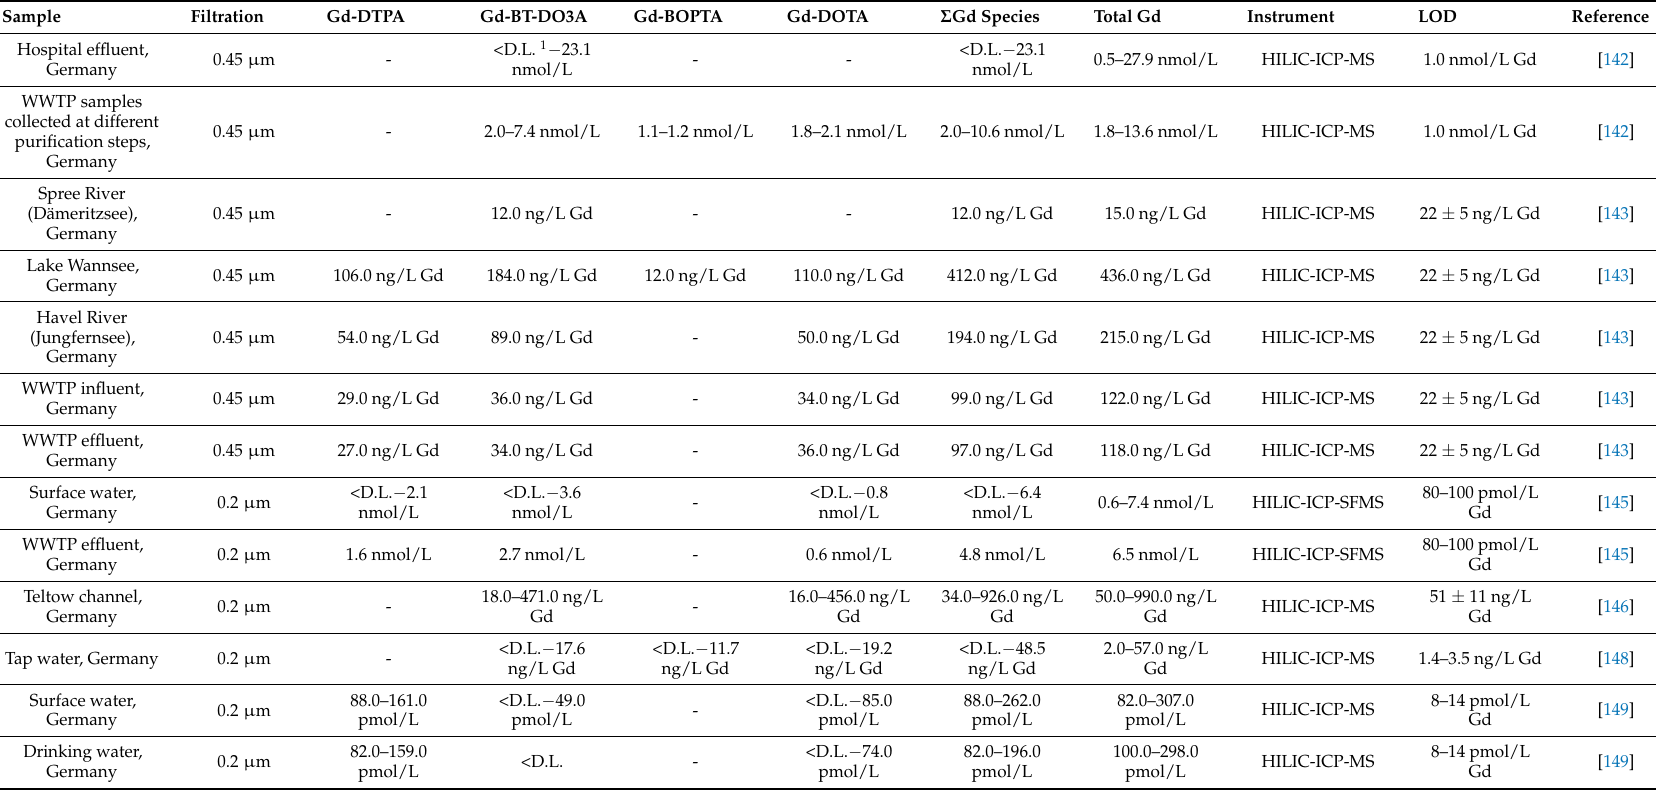
Table 6. Concentration of various Gd-based contrast agents in environmental samples. Total Gd was determined by means of